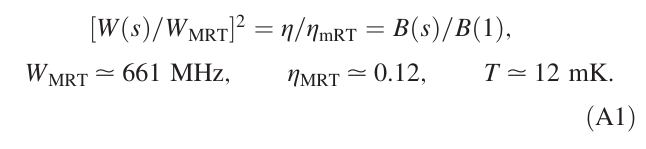
for time t and total annealing QA